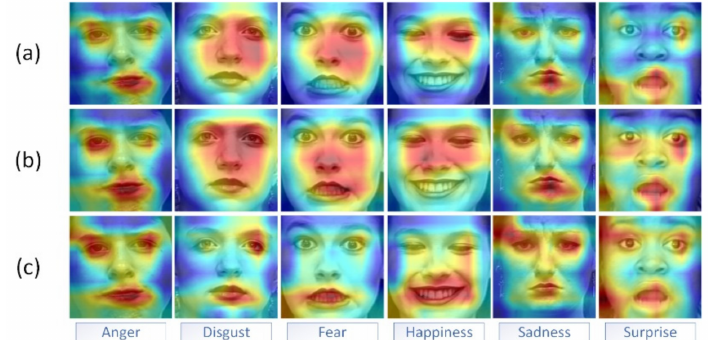
Figure 3. Visual comparison of gradient class activation mapping of CK+ (the three methods include the presence or absence of pyramids and single or cascading attention). From top to bottom, the visualization results are shown for the methods ( a ) without a pyramid but with cascading attention, ( b ) with a pyramid but with a single attention block, and ( c ) with a pyramid and cascading attention are shown in the expression images. We note that five subjects were included in these results: S055, S074, S106, and S111. The usage of their facial images is licensed. The use of their face images is